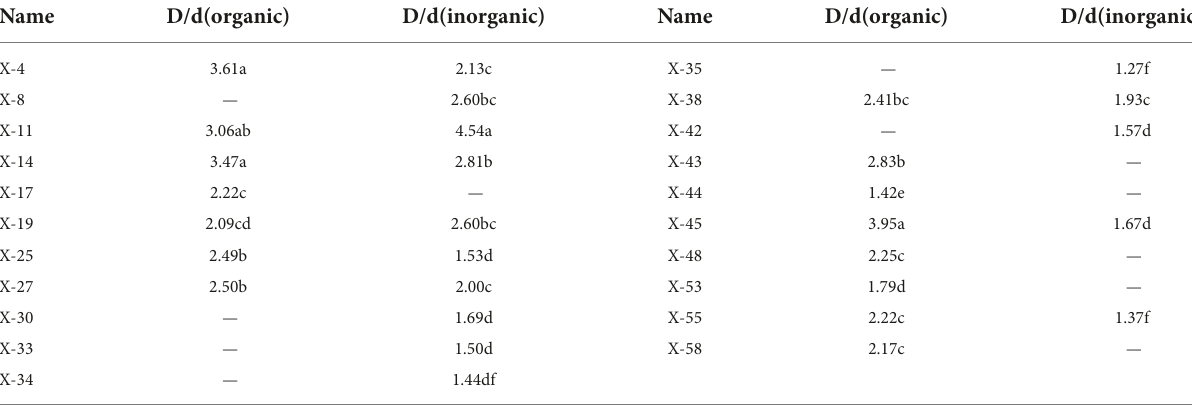
TABLE 2 Primary effect of phosphate-dissolving bacteria.